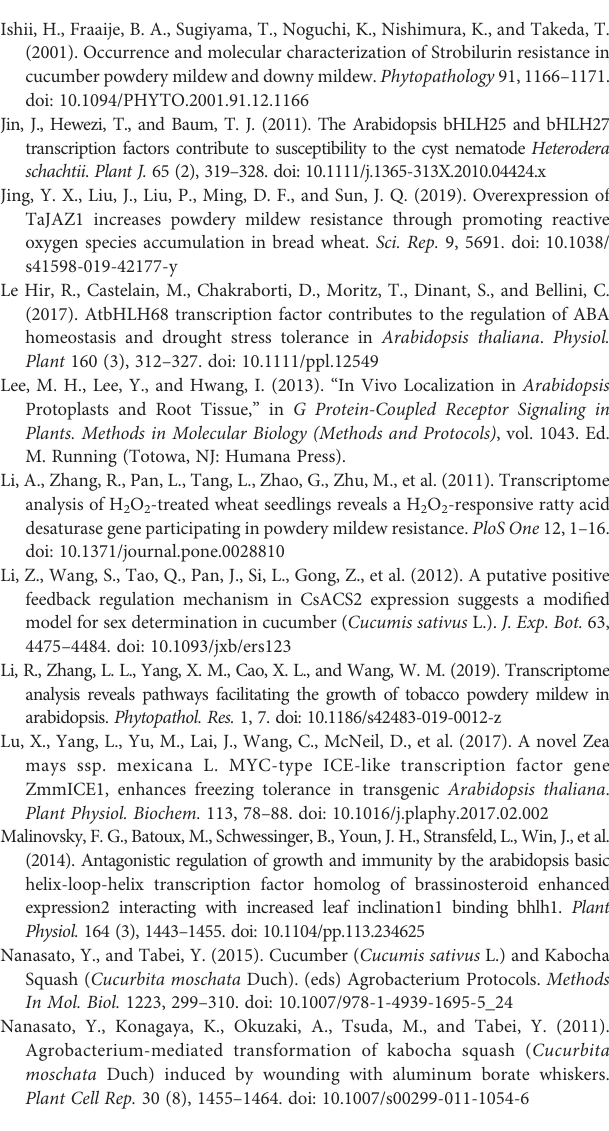
TABLE S1 | Primers used in this